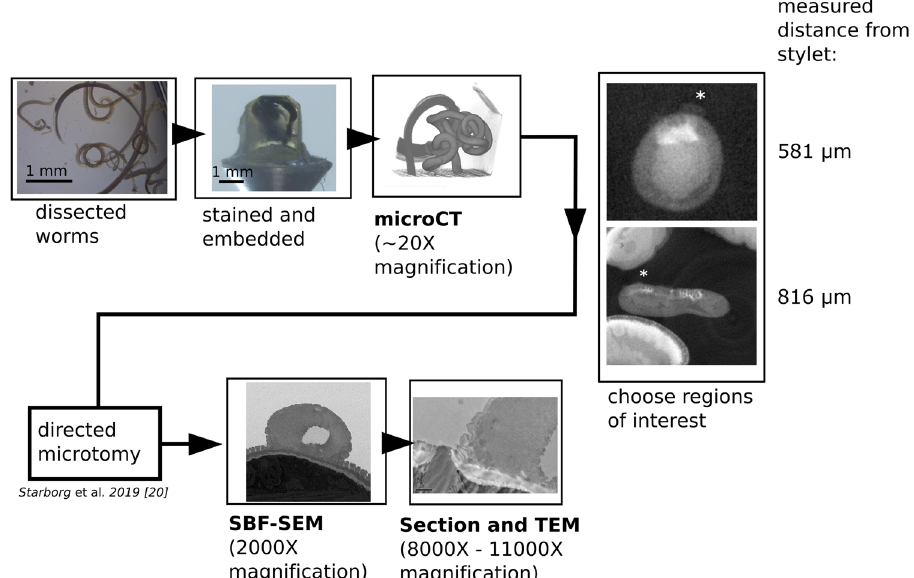
Figure 2. Schematic of the correlative workflow facilitating targeted electron microscopy of cuticular inflations. The worm is dissected from the host 35 days after initial infection, and processed for SBF-SEM. The worm is stained with osmium tetroxide, uranyl acetate and lead aspartate, and is embedded in epoxy resin. CT provides a virtual “map” of the tissue from which regions of interest, including the cuticular inflations ( * ) can be identified. After trimming the sample to expose the desired region of interest, SBF-SEM and TEM may be carried